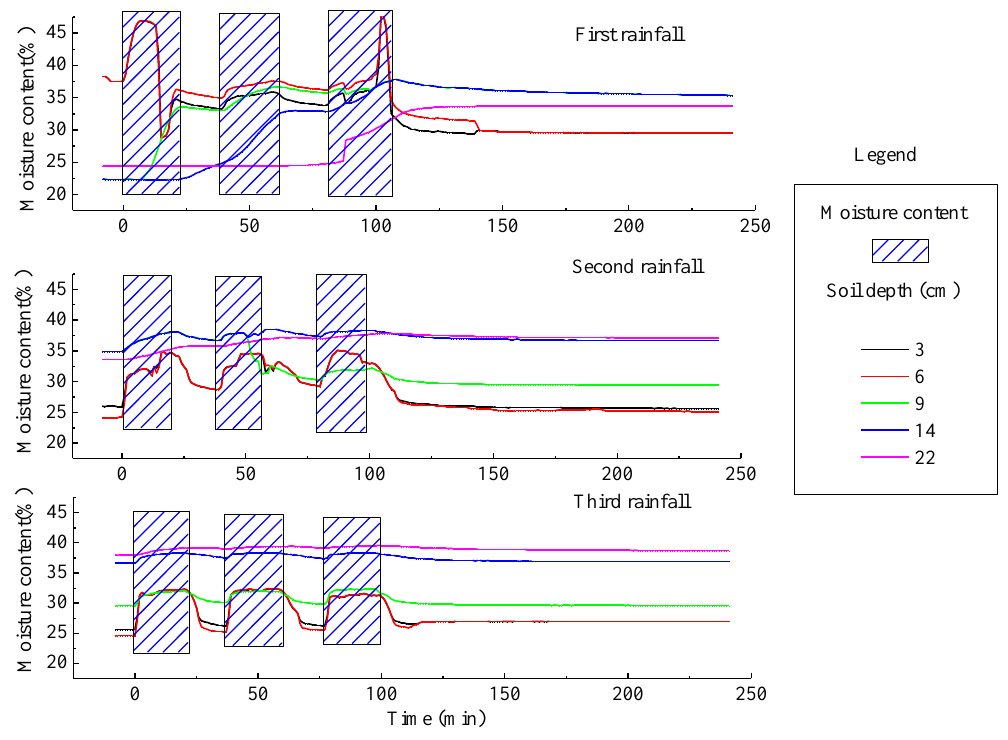
Figure 10. Dynamic change process of soil water content of the loess slope in 2.0 mm/min rain.